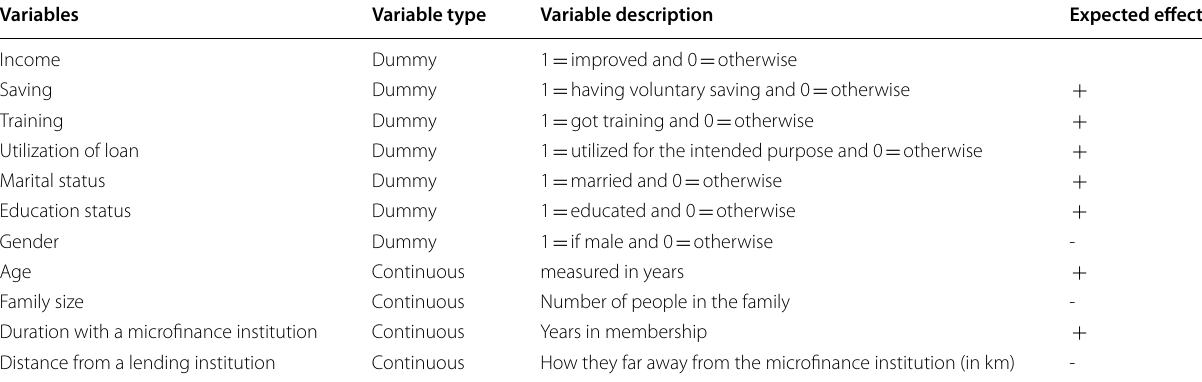
Table 2 Description of explanatory variables in the study. Source : Author’s Design Variables